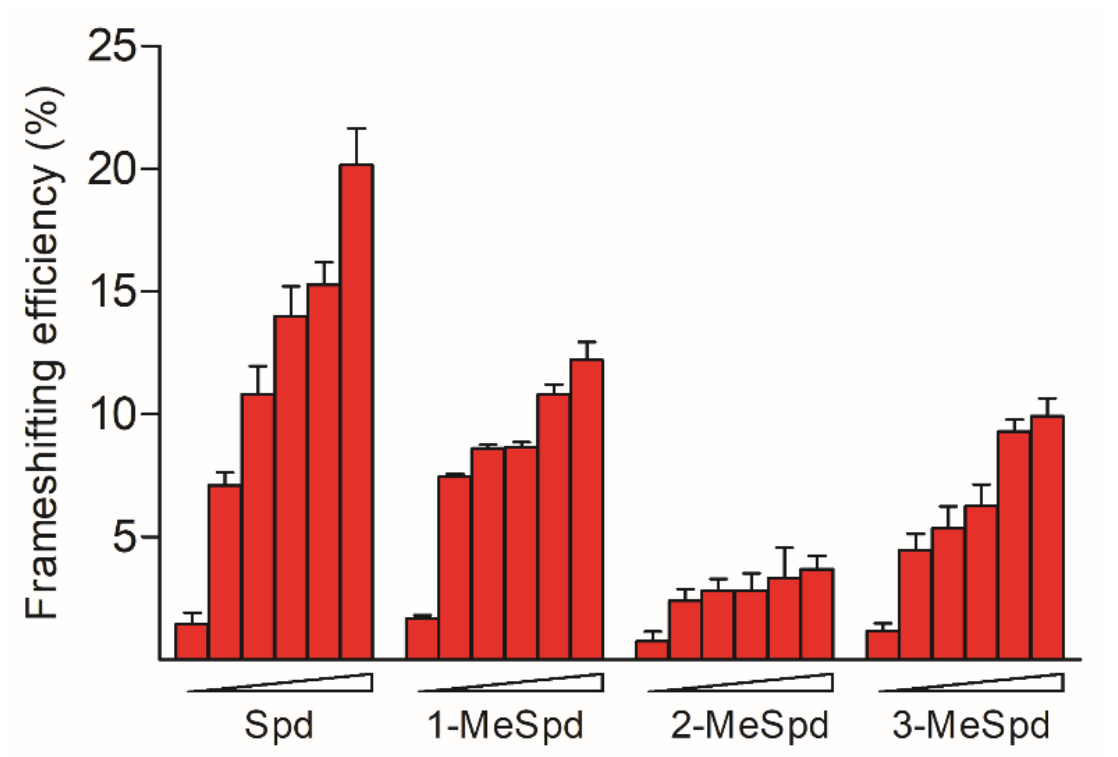
Figure 2. The effects of Spd and its C -methylated derivatives on the efficiency of the +1 frameshifting of eukaryotic OAZ1 mRNA. Average percent frameshifting in the spe 1, spe 2, paa 1, and fms 1 deletant strain of S. cerevisiae IS532/44d was measured using a bicistronic assay and plotted versus polyamine concentrations (0, 0.25, 0.5, 1, 2, and 4 mM) in the medium. The IS532/44d strain of S. cerevisiae was transformed with pAC98T-OAZ1-FS or pAC98T-OAZ1-Cont plasmids, and luciferase activity was measured and then normalized to β -galactosidase activity essentially as described in [28]. Error bars